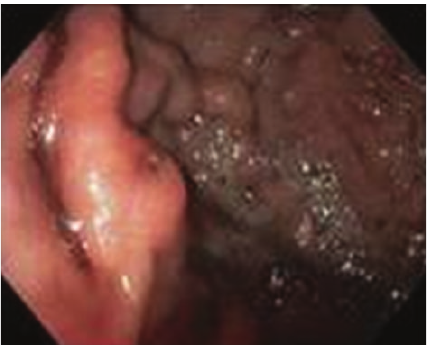
Figure 4: EGD demonstrated a gastric varix with erosion.